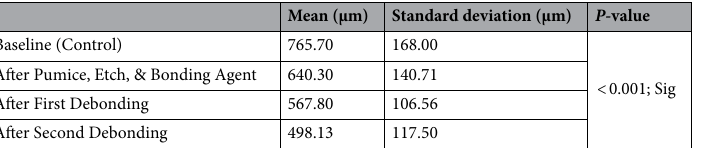
ranges. This allowed visualizing the internal enamel structures with more clarity when compared to conven- tional grayscale OCT. The white arrows in the images indicate the enamel abrasion caused by different treatment procedures. It can be observed that the internal layers in magenta colored and red-colored are reduced in each treatment process with respect to the amount of enamel damage that occurred during the treatment process. In images F1-F3 that were obtained after bracket bonding and debonding is executed twice, the internal red and magenta colored structures are almost diminished (the region around white arrow). Moreover, we could see the additional accumulation of green segmented layers in the pumice, etch and bonding agent applied tooth sample (B1-B3), which could be due to the infusion of microstructures by a bonding agent. The green segmented layers that constitute most of the enamel structures appear to be visibly reduced in the successive treatment processes. Using the en face images obtained from the intensity-based layer segmented analysis of all tooth samples (the representative images for each treatment group is shown in Fig. 9 A2, B2, E2, and F2), the total enamel present in the tooth samples at 500 µ m below the tooth surface is calculated. The total enamel present in these images corresponds to the total pixel intensities in continuity in the en face images. The calculated values for enamel present for each treatment group, i.e., the average (mean), the minimum, and the maximum values along with